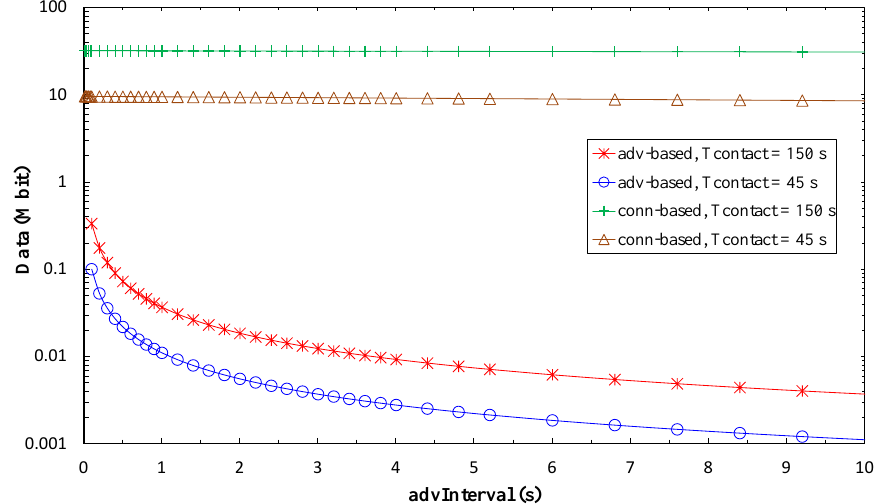
Figure 18. Maximum amount of collected data per contact interval, for the advertisement-based and connection-based approaches, as a function of advInterval , and for different T contact values. Only curves for connInterval = 4 s are shown, for the sake of figure clarity.